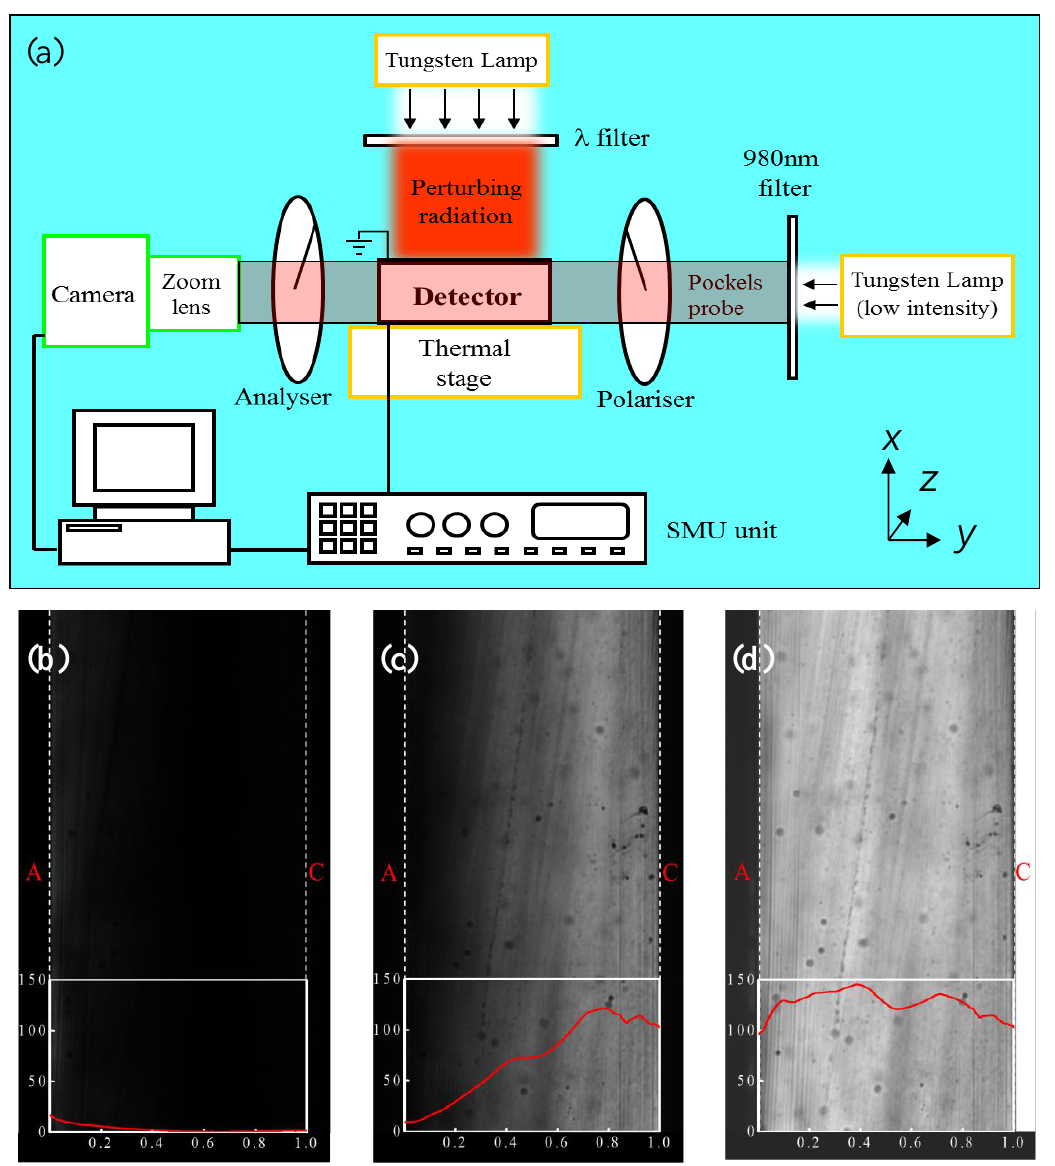
Figure 1. ( a ) Experimental set-up for Pockels effect measurements under optical perturbation. Typical Pockels image (polarisers crossed) of the unbiased detector ( b ) and ( c ) biased at 600 V in perturbation-free condition at T = 25 °C. Superimposed the intensity profile I ( y ) from anode (A) to cathode (C), calculated by averaging I ( x , y ) along the x- direction. ( d ) Image of the unbiased detector, with parallel polarisers ( I ( x , y )). 0 Superimposed the intensity profile I ( y ) from anode (A) to cathode (C), calculated by 0 averaging I ( x , y ) along the x- direction. The corresponding electric field profile E ( y ) is 0 shown in Figure 3 (dark squares). The dark spots visible in the images can be ascribed to Te inclusions/precipitates in CdTe crystal, and streaks to dicing crystal